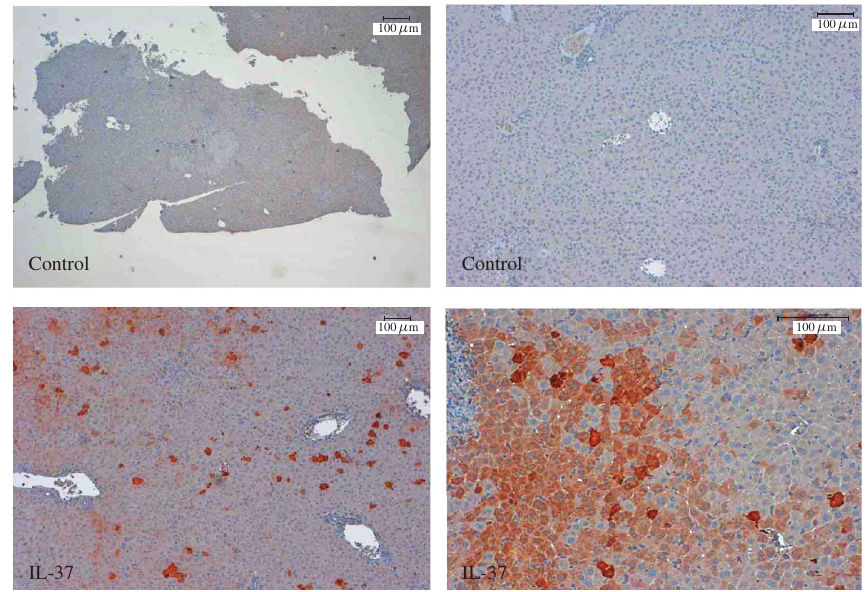
FIGURE 2: Detection of transgene IL-37 by immunohistochemistry. 5 μ m sections of mouse livers after plasmid-DNA injection with control plasmid (empty pTarget) or IL-37-pTarget were stained with a polyclonal antibody against IL-37.